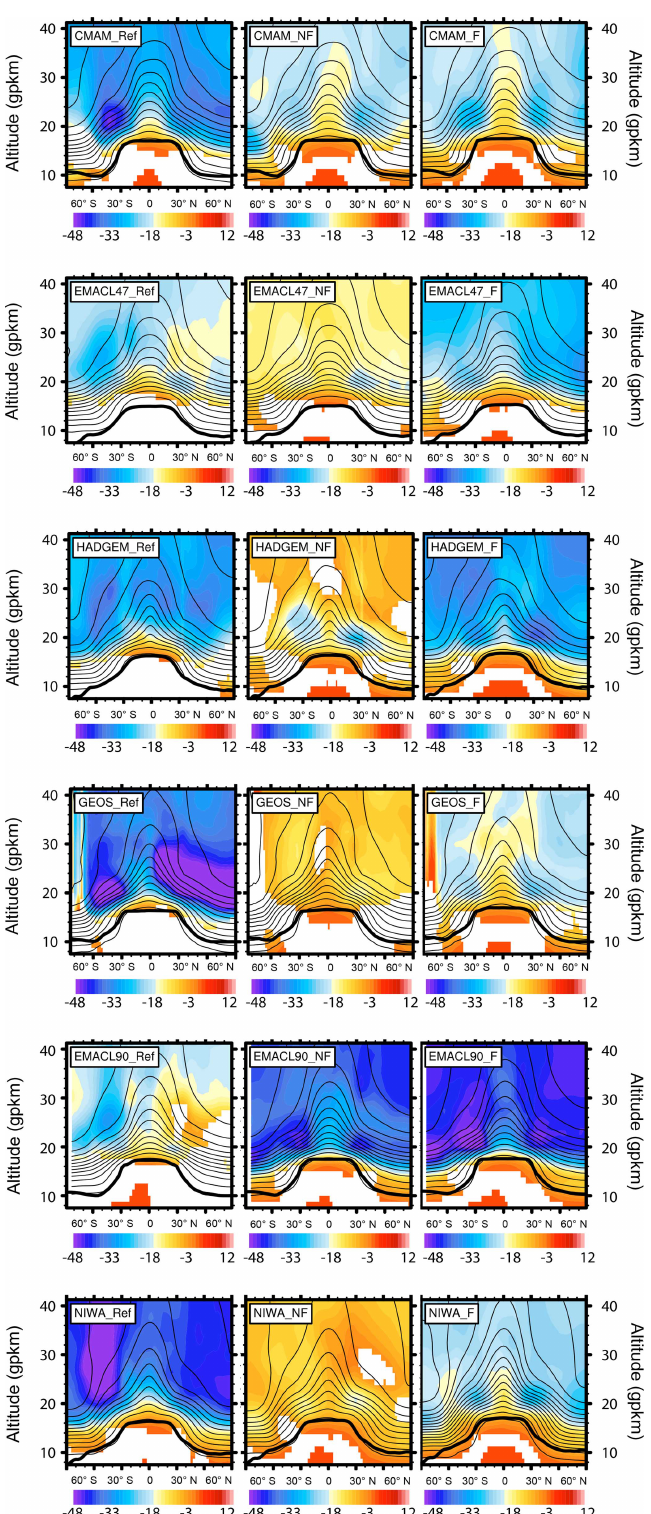
Figure 2. Zonal mean AoA trends (days per decade) (colors) and AoA climatology (contours) of the analyzed CCMI-1 REF-C2 simulations. The left column shows the Ref period, the middle column the NF period and the right column the F period. The vertical axis is in geopotential kilometers (gpkm). The mean tropopause position is indicated by the bold black line. White regions mark where the significance level of the trends does not exceed